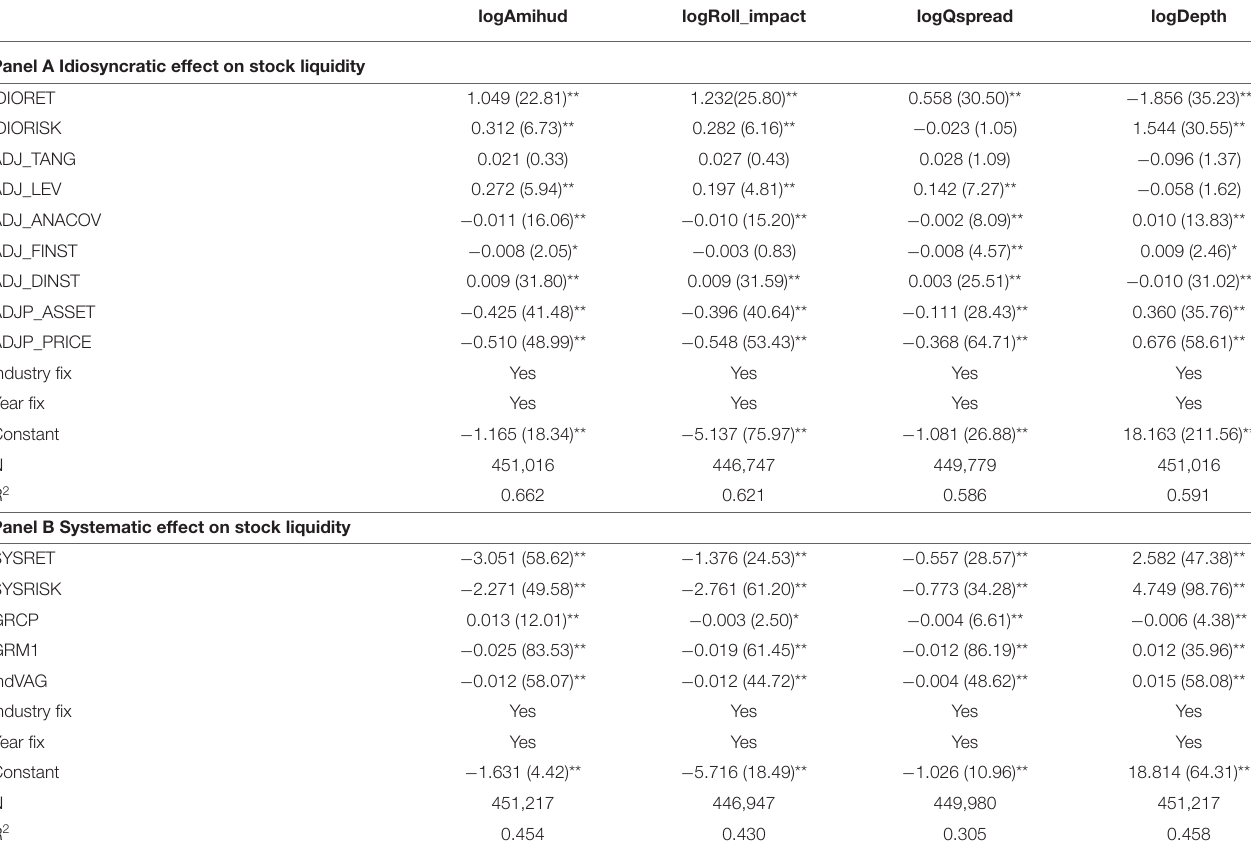
TABLE 3 | Contemporaneous impact of determinants on stock